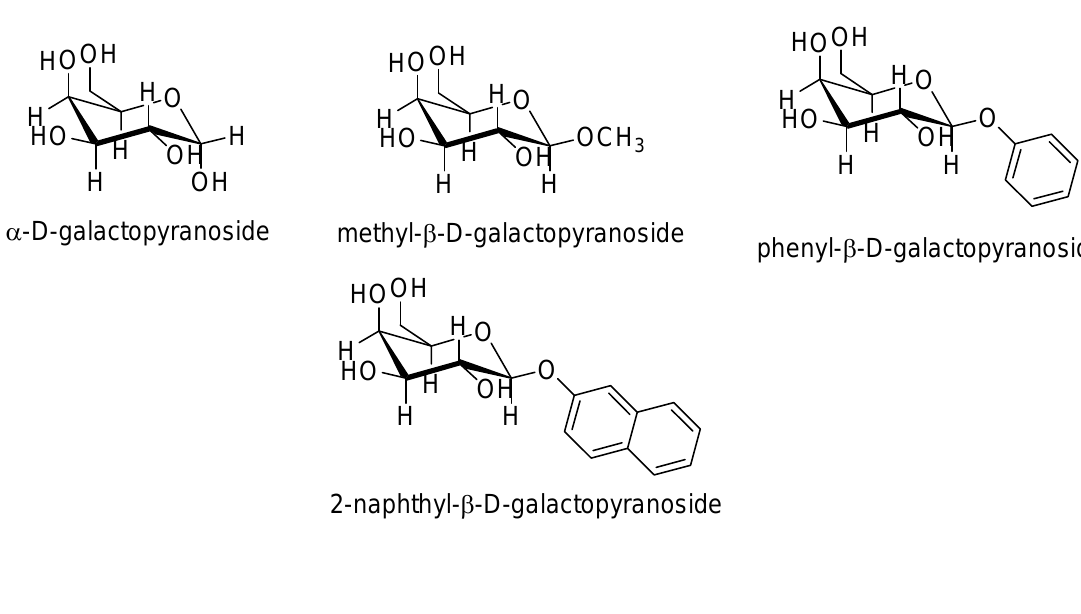
Figure 5. Structure of starting derivatives of galactose used as potential counterions.